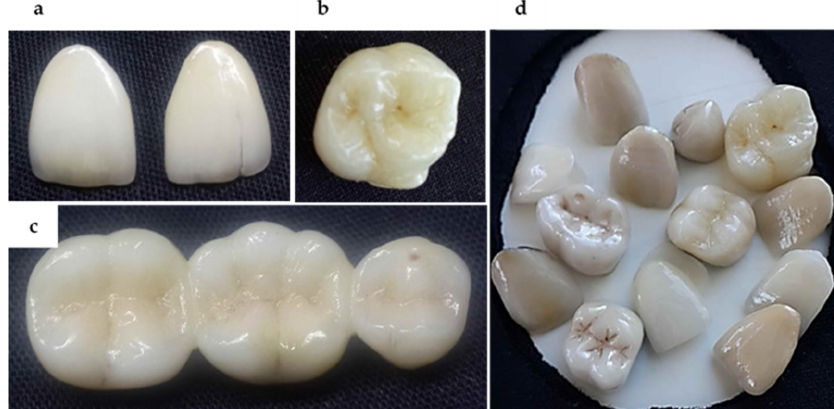
Figure 3. The indirect porcelain restorations demonstrating excellent esthetic properties; ( a ), anterior crown ( b ), posterior crown ( c ), bridge and ( d ), multiple indirect restorations showing variations in color, translucency and stains to match patients’ natural teeth. color, translucency and stains to match patients’ natural